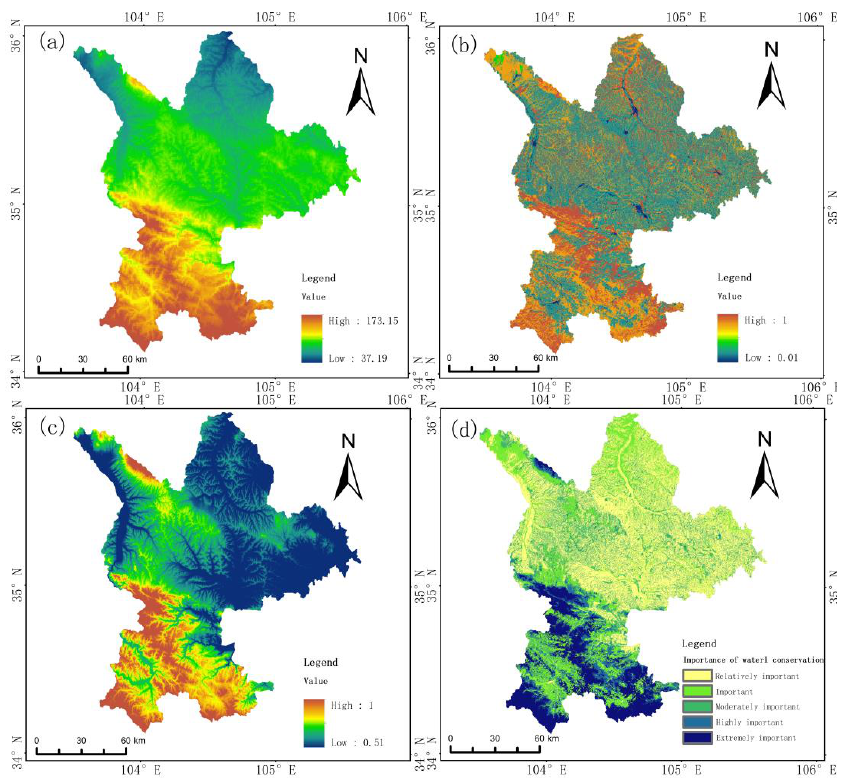
Figure 4. ( a ) Average runoff depth from 1980 to 2015; ( b ) characteristic vegetation factors of water conservation importance; ( c ) surface cover factors of water conservation importance; and ( d ) classification of water conservation importance.